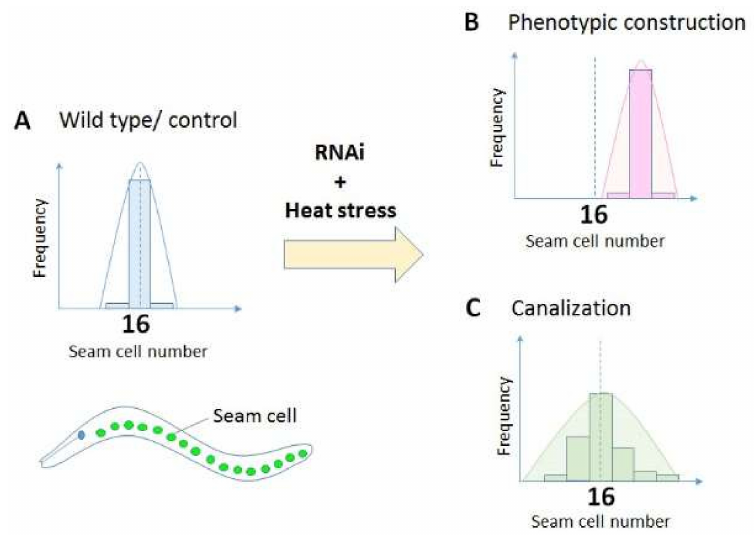
Figure 1. Measurement of canalization using seam cell numbers as a read-out in Caenorhabditis elegans . Most wild type worms have 16 seam cells in the lateral side of the body at L4 larval stage ( A ). If a gene is involved in phenotypic construction [18], knockdown of the gene alters the mean seam cell number ( B ). However, if a gene is involved in the canalization of seam cells, knockdown of the gene would increase the variance of seam cell numbers ( C ). See details of the experiments in Section